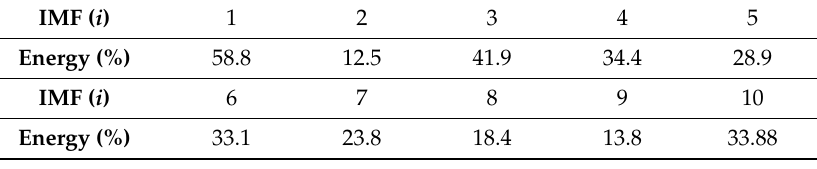
Figure 8. IMFs and the tendency function of bearing damage signal. Table 2. The energy of each IMF of current signals.